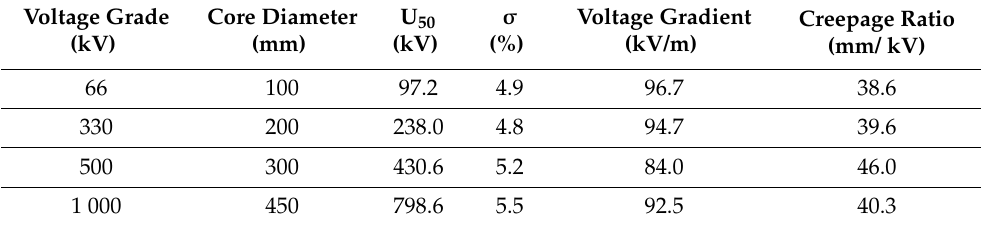
Table 4. Pollution flashover test results of composite crossarm insulators with different core